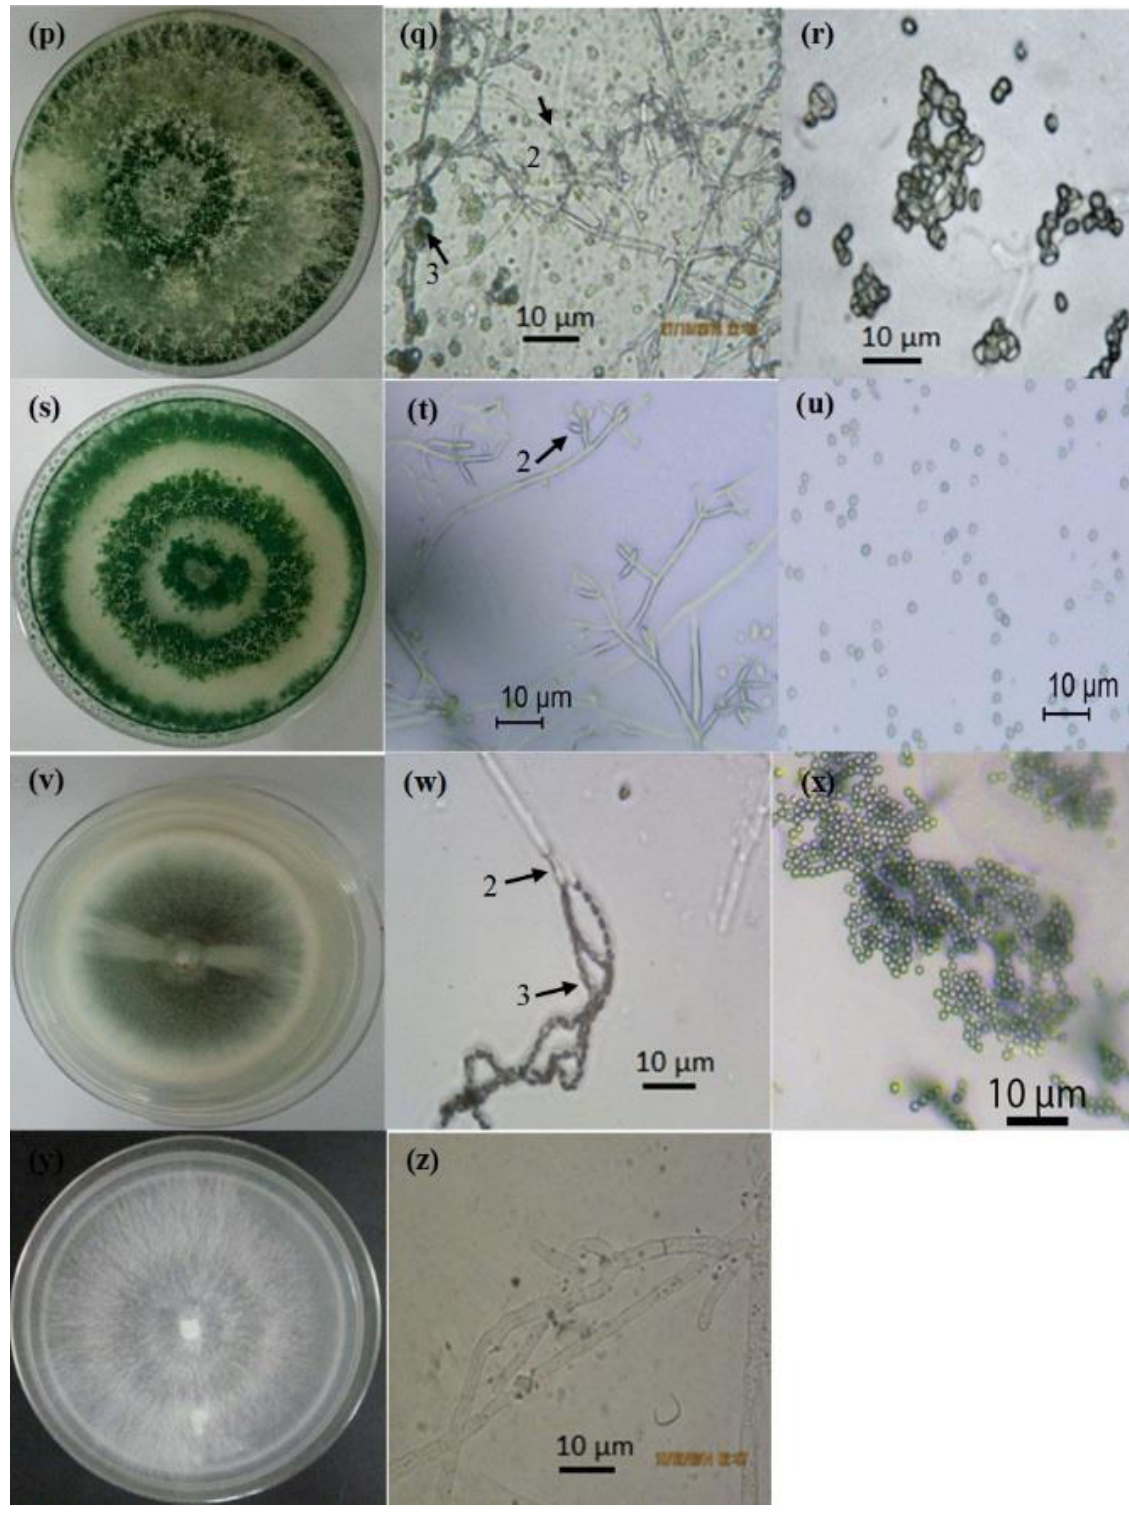
Figure 2 (Part 2). Macroscopic and microscopic characteristics of isolated fungi from Alan Bunga peat swamp forest ecosystems. Trichoderma asperellum :- p) Colony appearance on malt extract agar (MEA); q) Conidia formed at the tip of conidiophore, spore mass, phialides; r) Conidia; Hypocrea muroiana :- s) Colony appearance on MEA; t) Conidiophore, phialides; u) Conidia; Penicillium sp.:- v) Colony appearance on MEA; w) Conidia formed at the tip of conidiophore, spore mass, metula, phialides; x) Conidia; Phanerochaete chrysosporium :- y) Colony appearance on MEA; z) septate hyphae. Arrows indicate: 2) phialides; 3) conidia